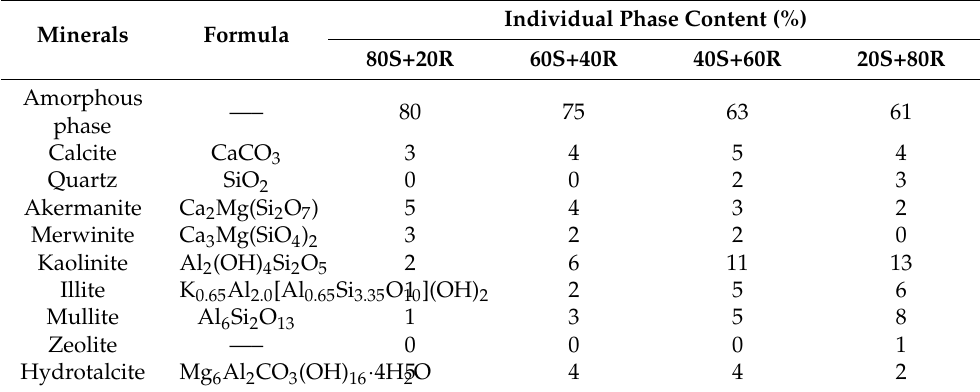
Figure 3. Comparison of two extreme activated products: 20S+80R and 80S+20R. Explanatory notes: Kao, kaolinite; Ill, illite; Zeo, zeolitic structure; Hyd, hydrotalcite; Ak, akermanite; C, calcite; Q, quartz; M, mullite. Table 4. Phase composition of the mixtures (XRD analysis).